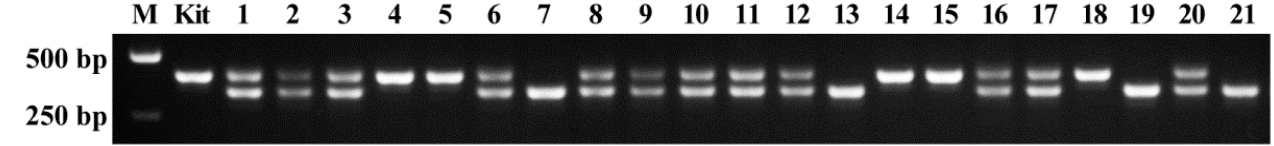
Figure 4. Genotype detection of offspring plants of iA/d68 T1 line using routine PCR. M, DNA marker; Kit, wild type rice Kitaake; and 1–21, the same plants of T2 segregation population detected in Figure 2D.